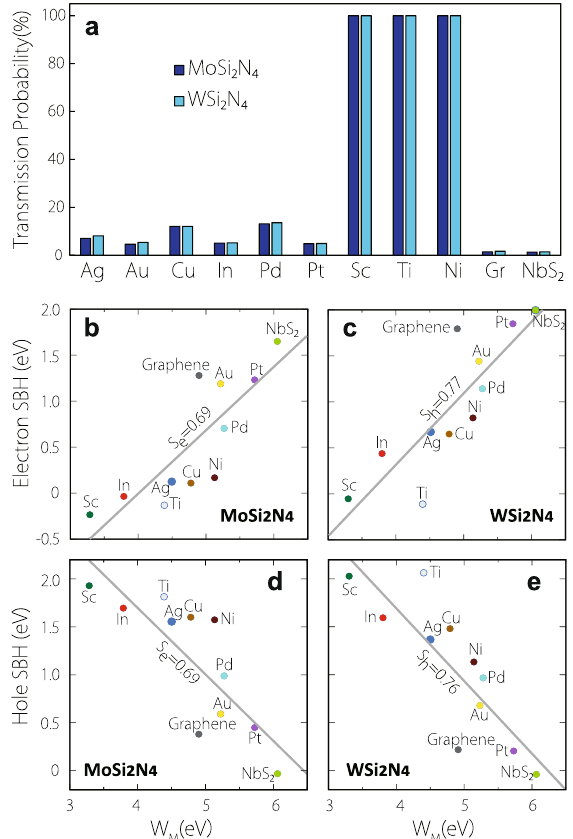
Fig. 5 T and SBH of the contact heterostructures. a Transmission probability ( T ) of various metal/MoSi 2 N 4 and metal/WSi 2 N 4 hetero- structures. b and c show the Schottky – Mott plot for the electron SBH of MoSi 2 N 4 and WSi 2 N 4 , respectively. d and e same as b and c , respectively, but for the hole